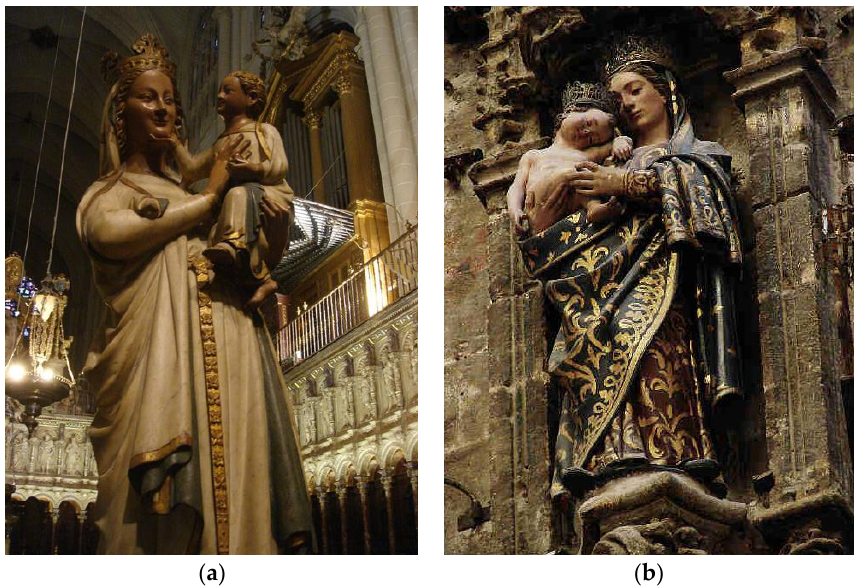
Figure A3. ( a ). Virgen blanca, second half of the Fifteenth fifteenth century, Toledo Cathedral (Toledo, Spain). ( left ) ; ( b ) . Virgen del Reposo de Norabuena, 1556, Seville Cathedral (Seville, Spain). ( right ). (3) Signs of Mary’s maternity.